Question: Write the caption for this figure.
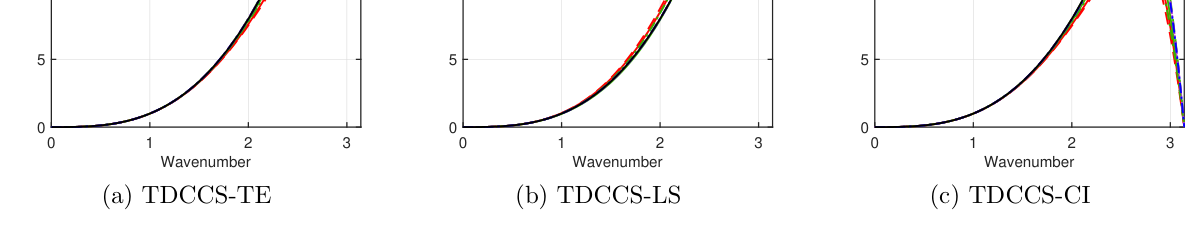
Answer: Plot of modified wavenumber versus wavenumber for (a) TDCCS-TE, (b) TDCCS-LS and (c) TDCCS-CI : (i) E4; (ii) E6; (iii) T4; (iv) T6; (v) T8; (vi) P6; (vii) P8; (viii) P10.